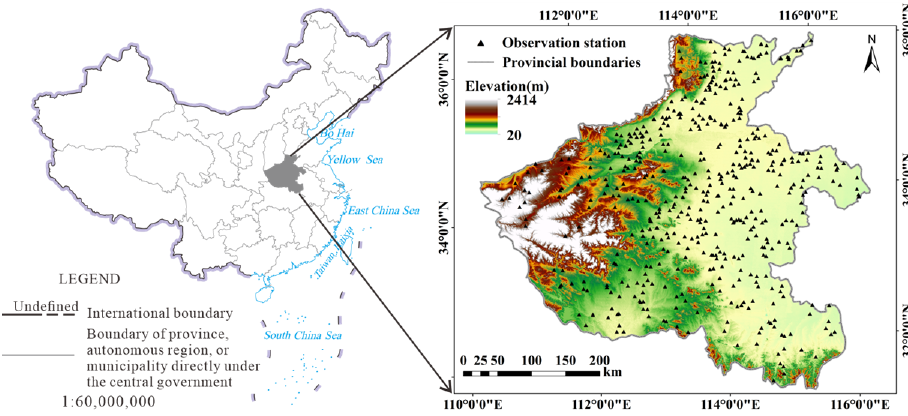
Figure 1. Location of study area and SM observation stations.